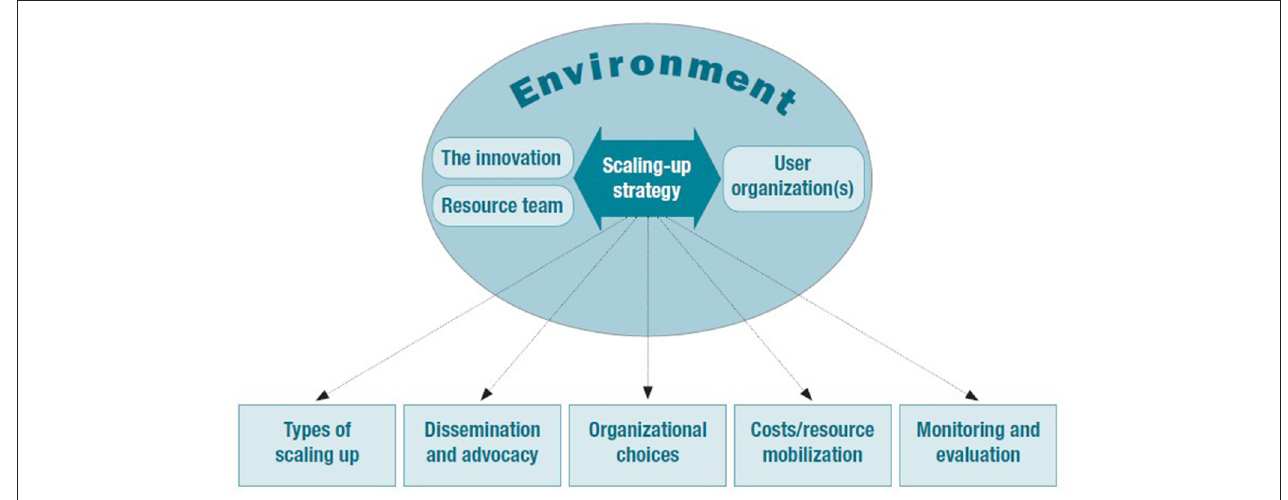
FIGURE 1 | WHO ExpandNet framework for scaling up. Reprinted from: